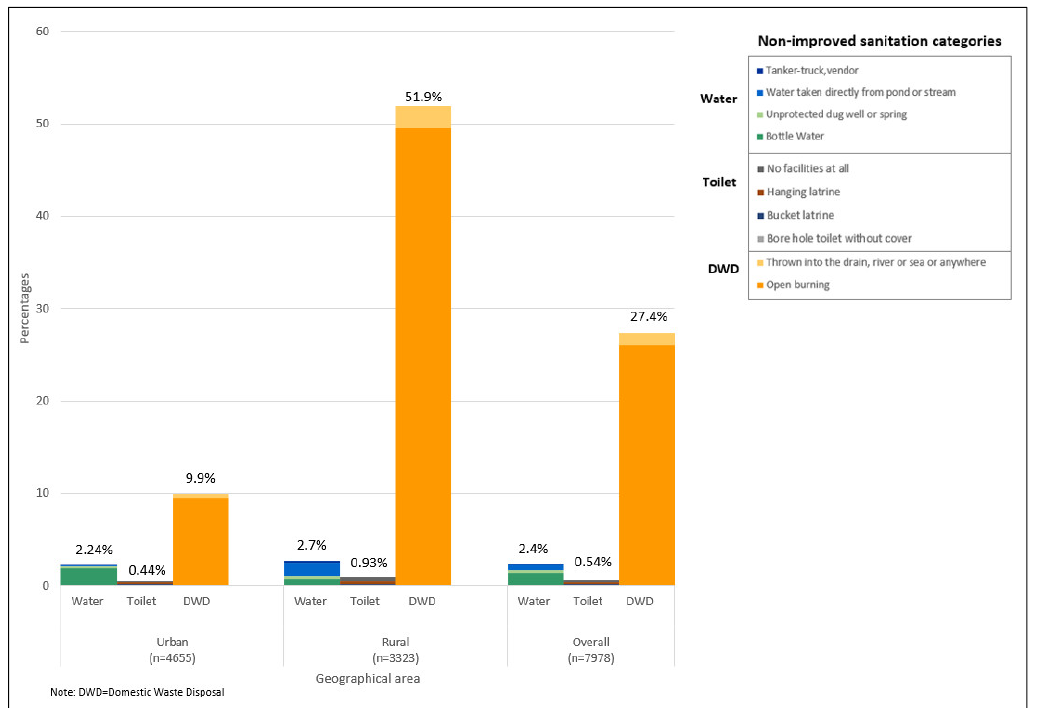
Figure 3. Non-improved sanitation categories by geographical location.